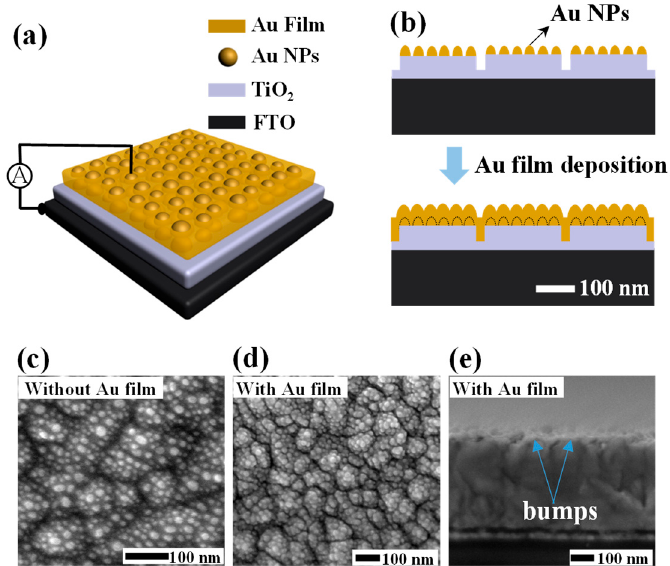
Figure 1. ( a ) 3D schematic diagram of the proposed plasmonic HEPD with a configuration of FTO/TiO 2 /Au NP/Au film. ( b ) 2D cross-sectional diagram of the HEPD illustrating the conformal deposition process for preparing the transparent Au film. ( c , d ) Top-view SEM images of the FTO/TiO 2 /Au NP multilayer sample and the proposed HEPD. ( e ) Cross-sectional SEM image of the proposed HEPD.